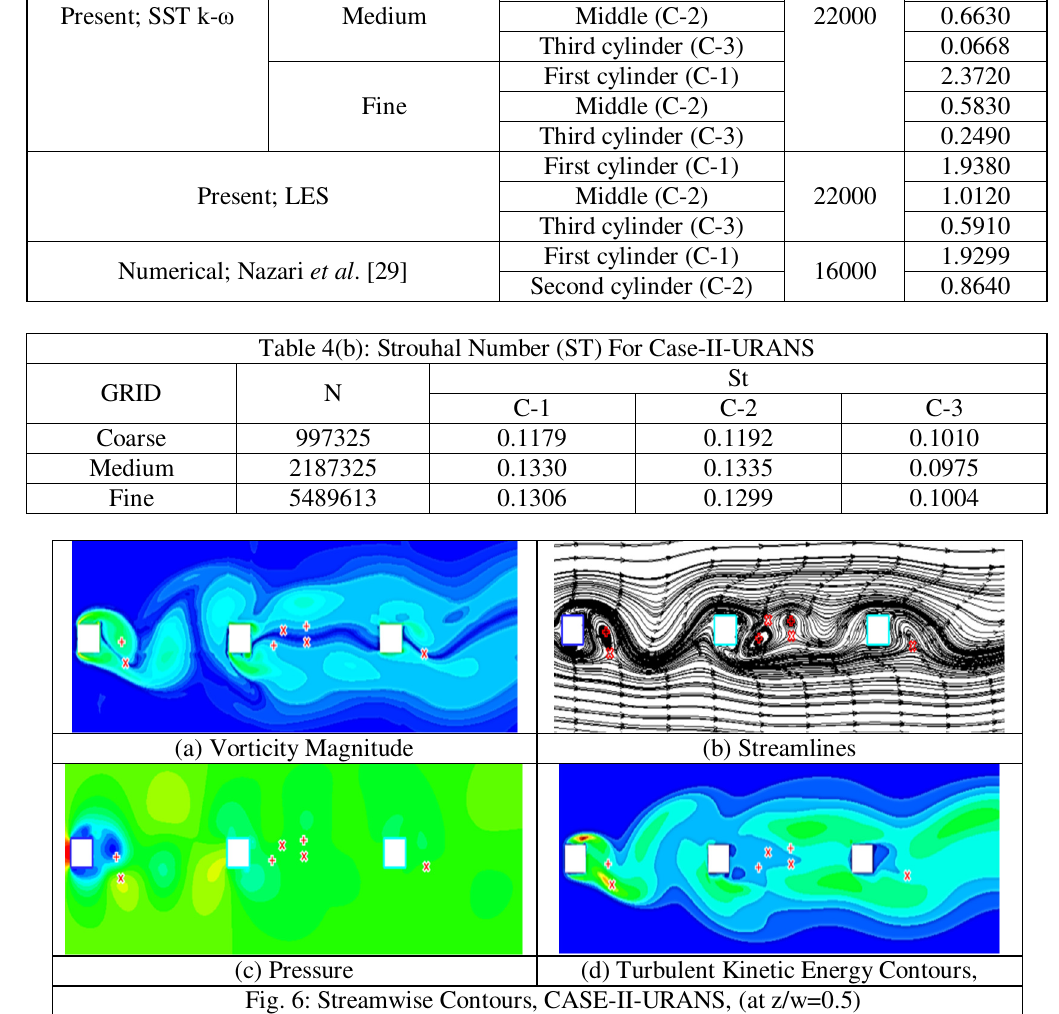
Fig. 6: Streamwise Contours, CASE-II-URANS, (at z/w=0.5)